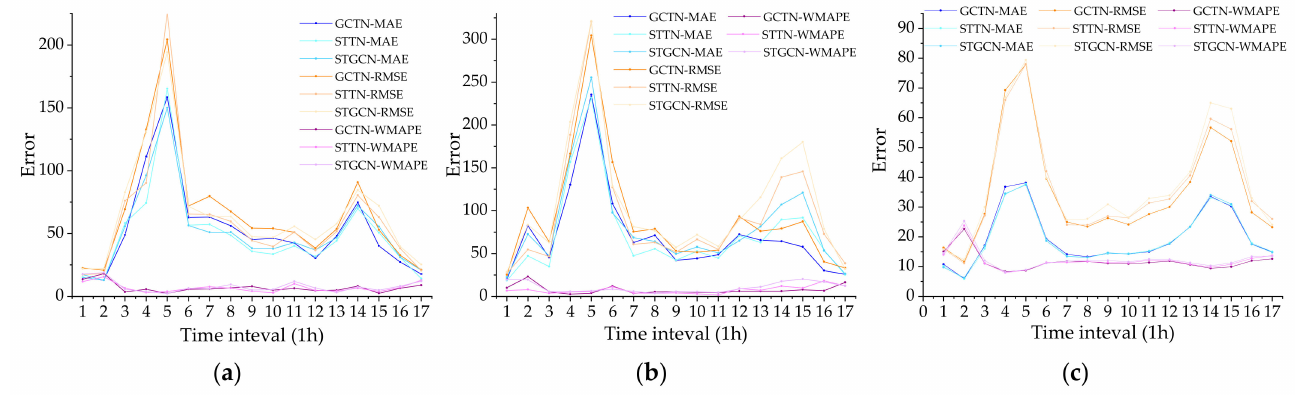
Figure 16. Outflow prediction performance of different times in the working day, with each time interval of 60 min. ( a ) Xujiahui station; ( b ) People’s Square station; ( c ) All